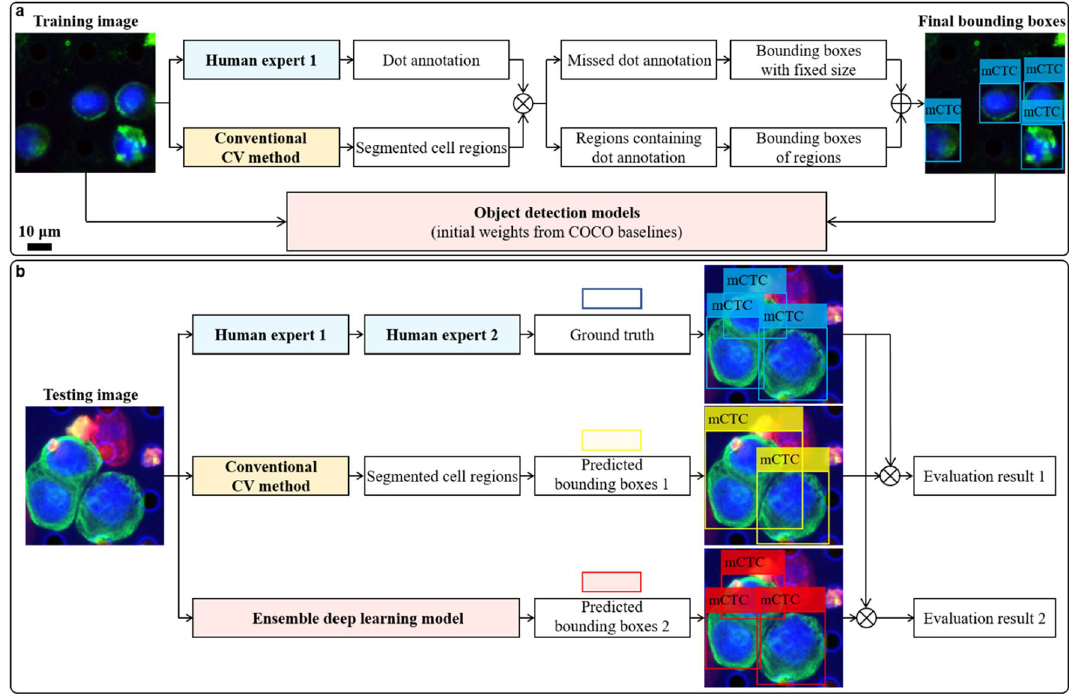
Figure 5. Cell detection via deep learning. ( a ) Training pipeline. An experienced pathologist annotates the cells of interest in training images with dots and simultaneously these images are processed by a conventional computer vision (CV) method to segment cell regions. Results from both methods are cross validated by matching annotation dots and segmentation regions. Any region containing annotation dots is used to generate a bounding box and paired with the annotation label. For dots which do not lie in any region, a bounding box centered at each of them is generated with the size of empirical cell diameter. Then, training images and